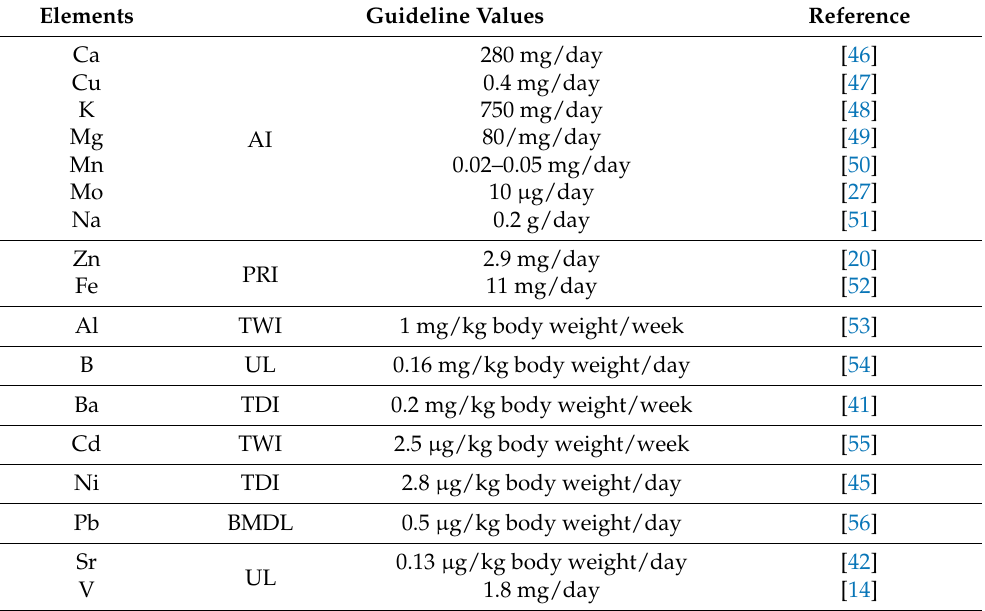
Table 1. Guideline values.